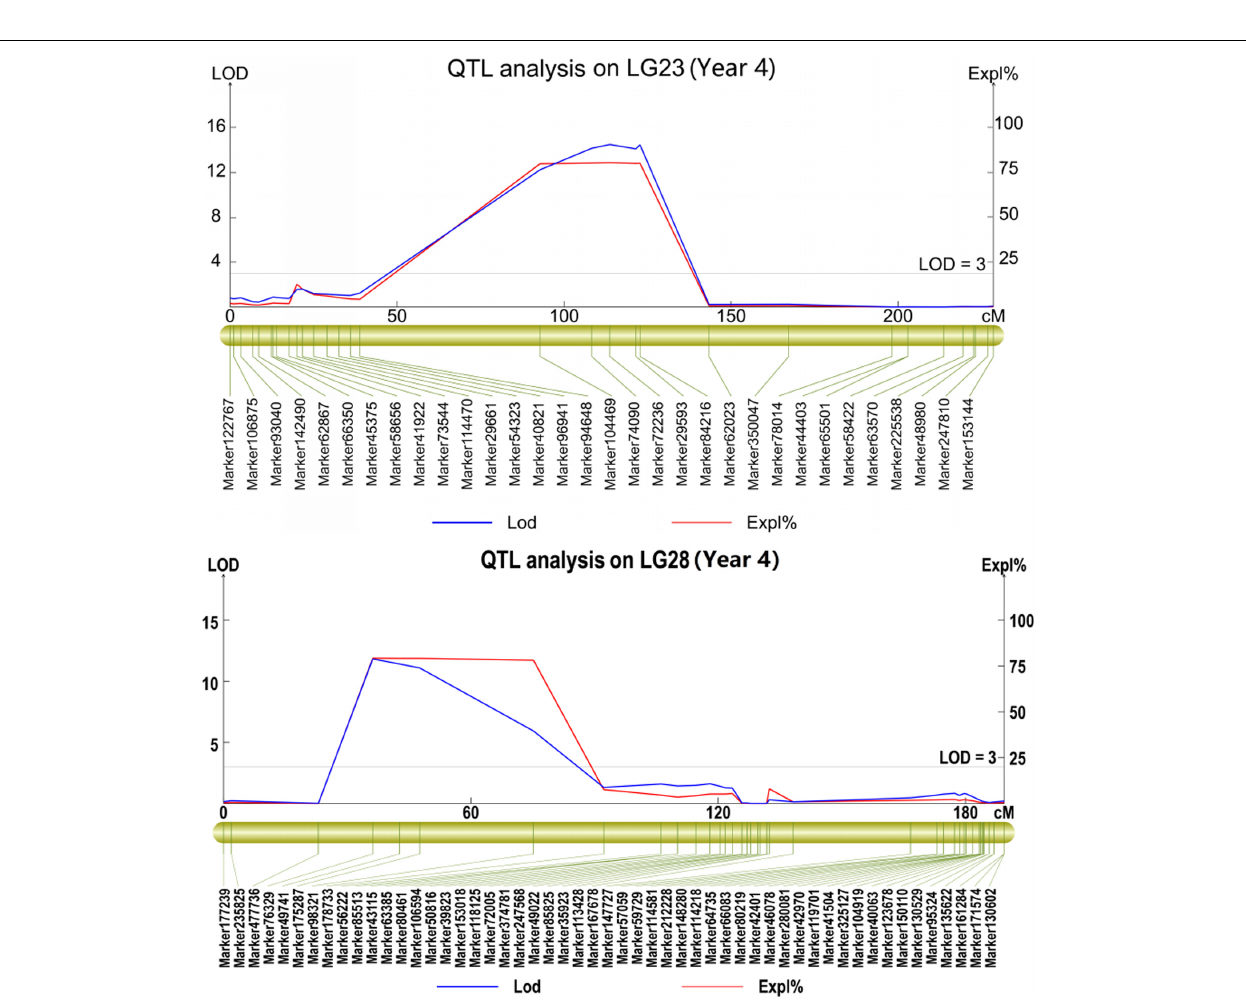
Frontiers in Plant Science |